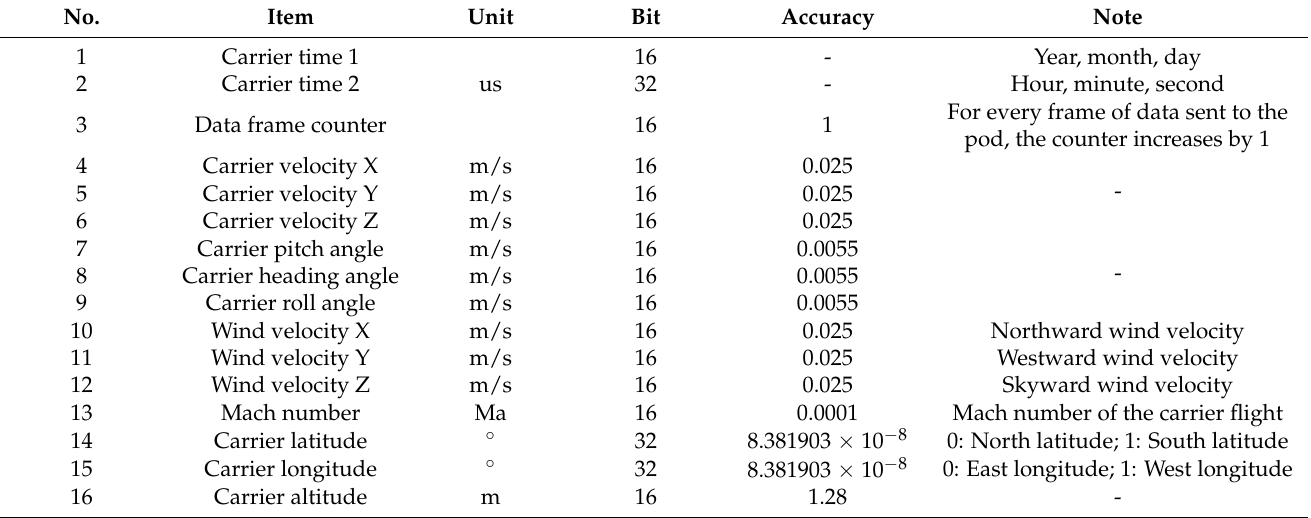
Table 3. Mission parameters.